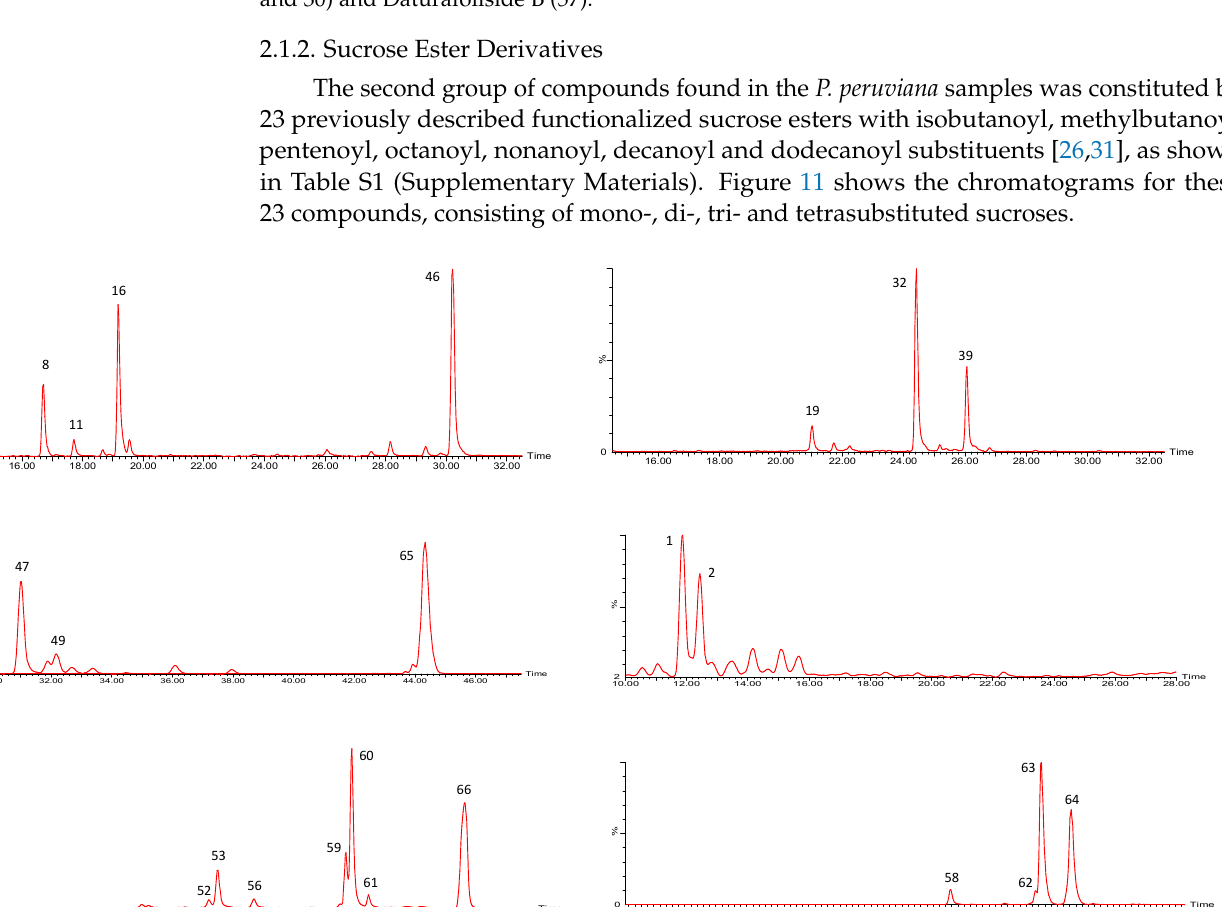
Figure 10. Structure and main fragments of Physalolactone B-3-O-β-glucopyranoside isomers (23 and 30) and Daturafoliside B (57).